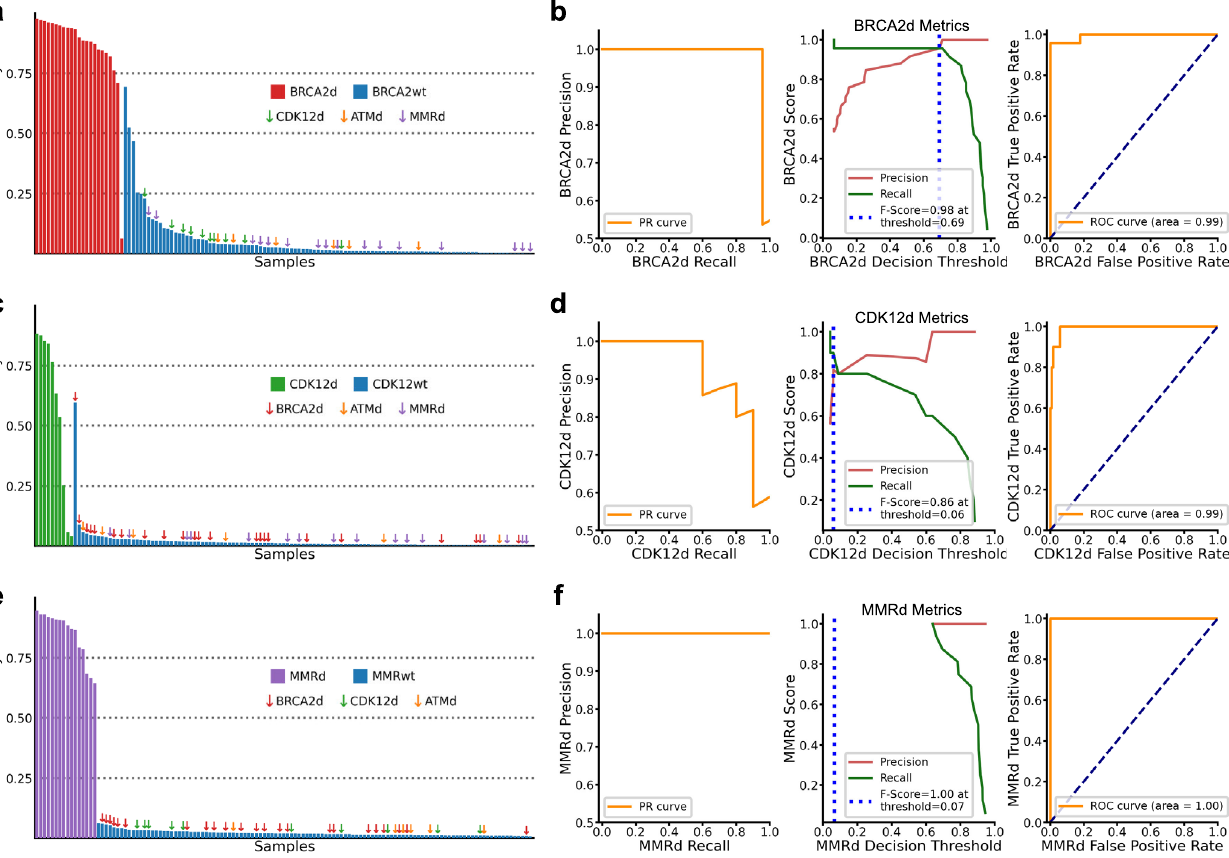
Fig. 3 Performance of the DARC sign classi fi cation models. a , c , e Predicted probabilities of binary class membership for each of the three models, for all metastatic prostate cancer samples. b , d , f Associated classi fi er metrics for the performance of each model, based on the original labels. Measures include precision-recall curve (left), precision (red) and recall (blue) as function of decision threshold (centre) and ROC/AUC curves (right). Threshold (blue dotted line in centre panel) was determined as the minimum threshold to achieve the maximum F-score (see “ Methods ”